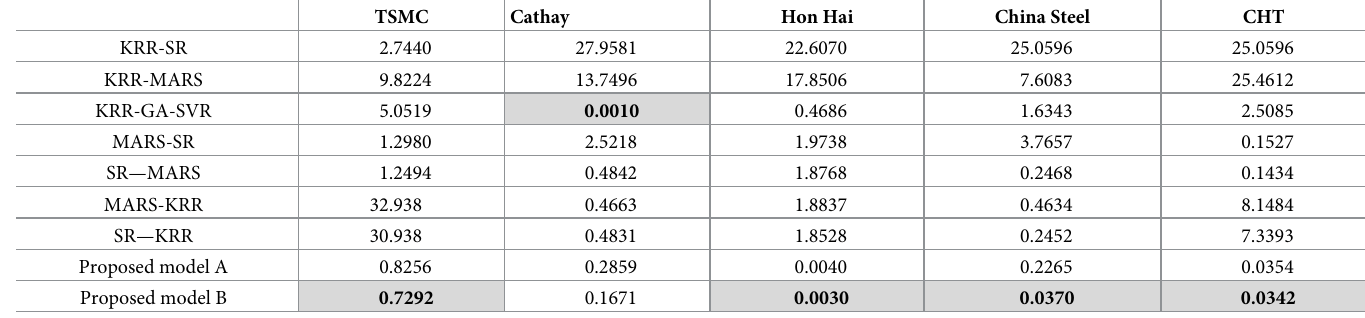
Table 16. The RMSE of all experiment for short testing period.